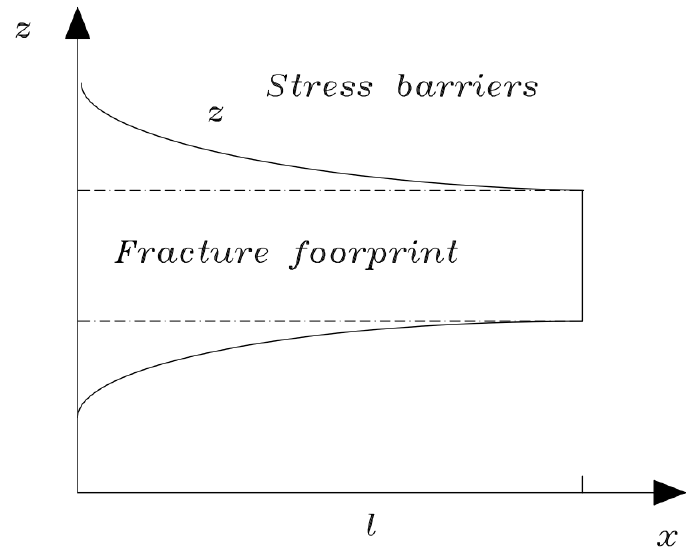
Figure 7. Schematics of the P3D fracture: x -axis is the direction of fracture extension; l is the length of fracture and z -axis is the height direction of fracture extension.